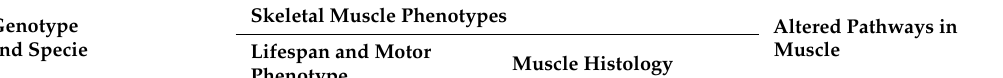
Table 2. Main fish and mammalian models for